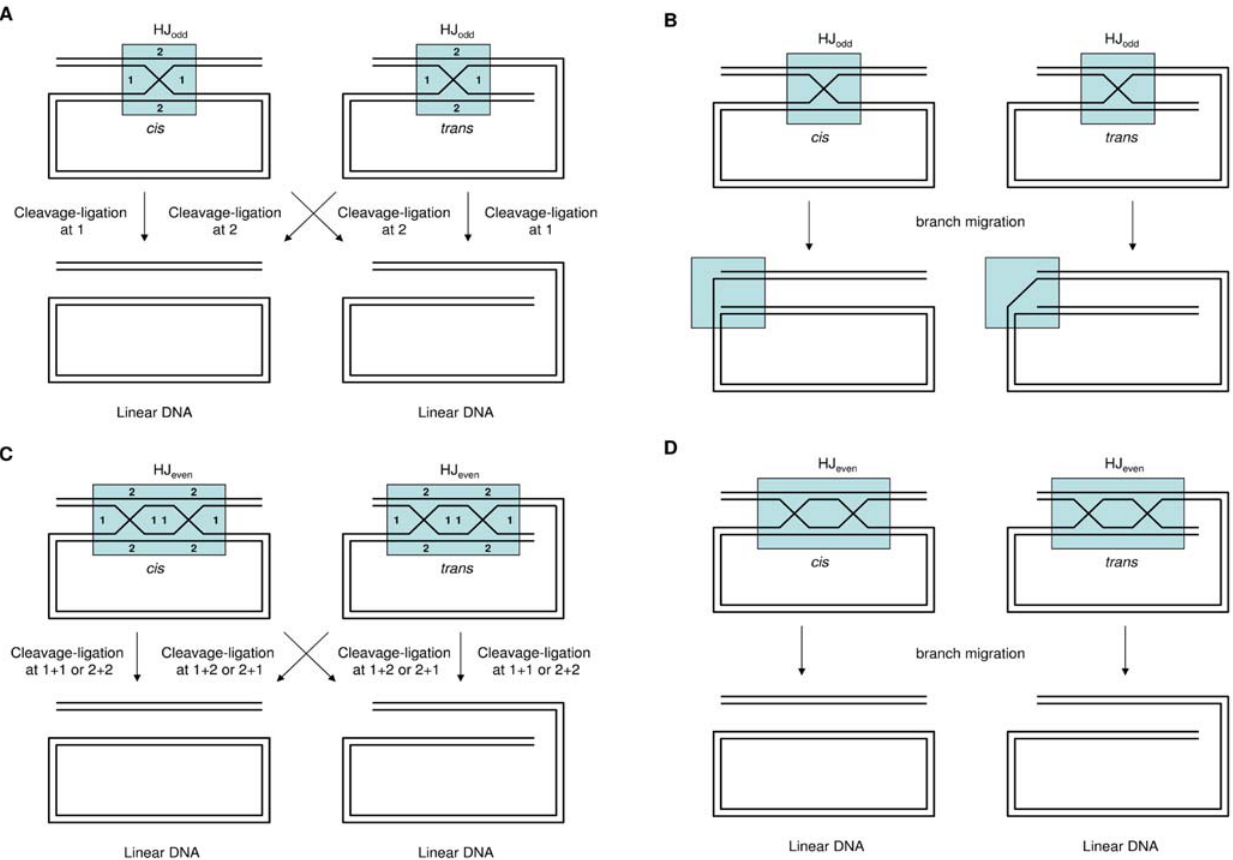
Figure 6. Illustration of how linear DNA can be generated by cleavage-ligation or branch migration of Holliday junctions in the context of a circular chromosome. A. cis and trans configurations of DNA ends on a linear fragment are joined by an odd number of Holliday junctions. Cleavage-ligation of the junctions liberates the linear DNA. B. cis and trans configurations of DNA ends on a linear fragment are joined by an odd number of Holliday junctions. Branch migration will not liberate linear DNA. Instead it will convert an alpha-shaped molecule to a sigma- shaped molecule. C. cis and trans configurations of DNA ends on a linear fragment are joined by an even number of Holliday junctions. Cleavage- ligation of the junctions will liberate linear DNA. D. cis and trans configurations of DNA ends on a linear fragment are joined by an even number of Holliday junctions. Branch migration of the junctions will liberate linear DNA.